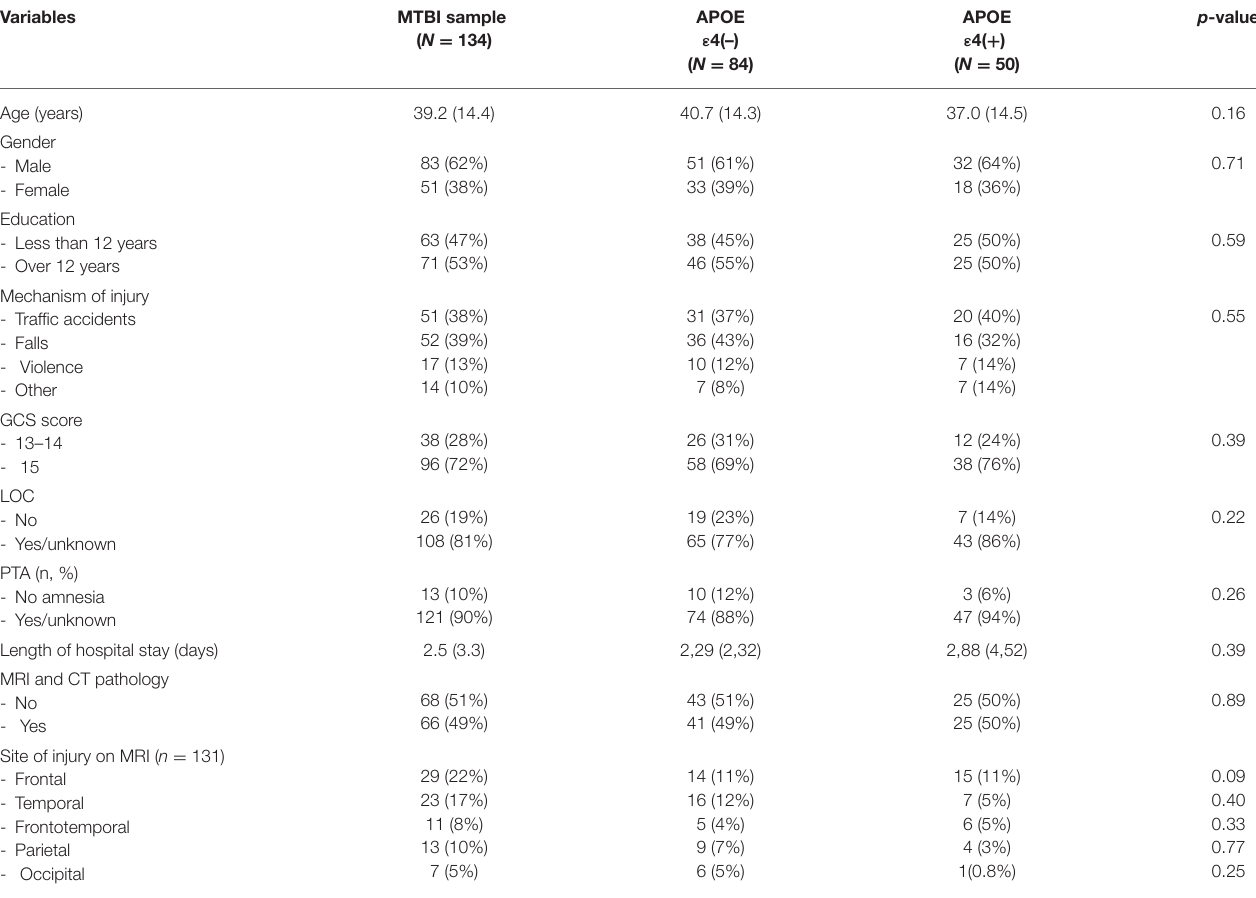
TABLE 1 | Demographics and injury-related characteristics stratified by the APOE- ε 4 status groups.